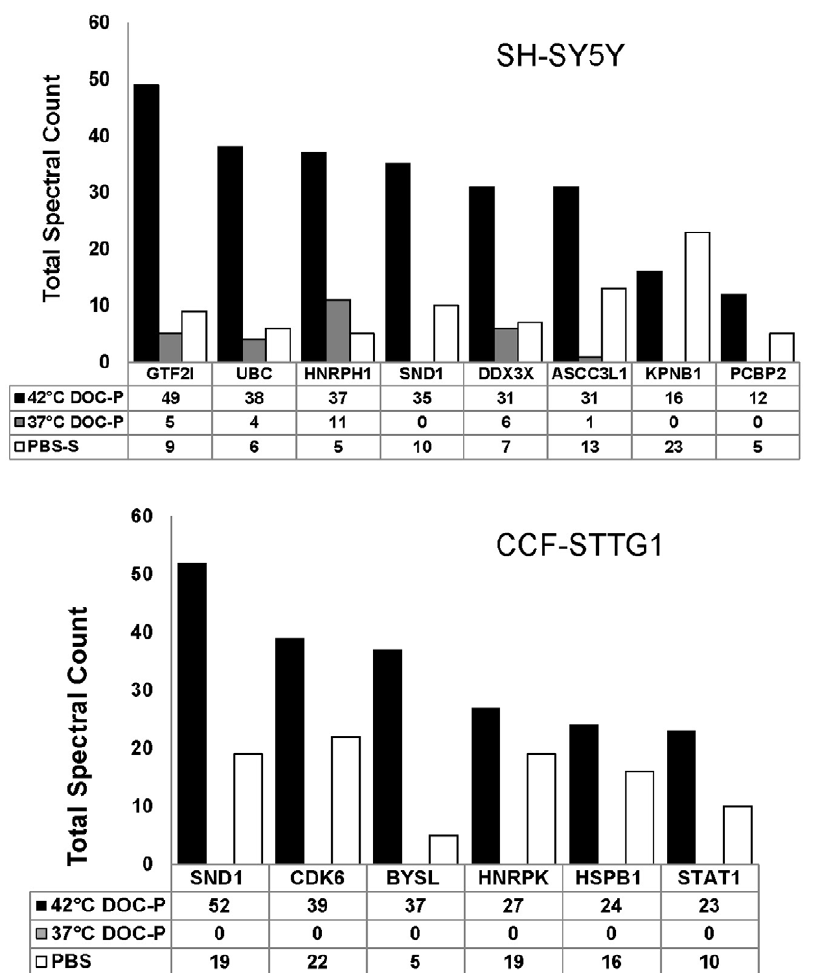
Figure 3. Spectral counts of proteins identified as over-represented in DOC-insoluble fractions of SH-SY5Y cells and CCF-STTG1 cells. Upper and lower panels, graphs spectral counts for proteins in SH-SY5Y and CCF-STTG1 cells, respectively, that were found in PBS-S as well as DOC-P fractions. Data were compiled from 2 separate proteomic analyses. The numbers graphed are sums of spectra numbers for the 2 experiments.